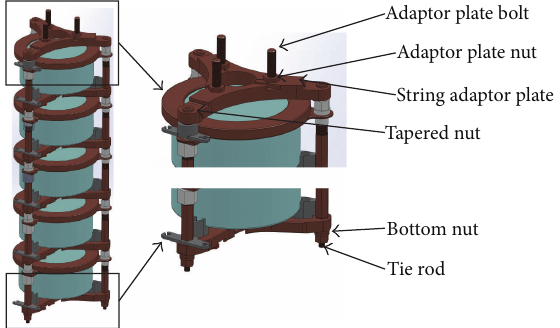
Figure 5: A rendering of the string design (see text for